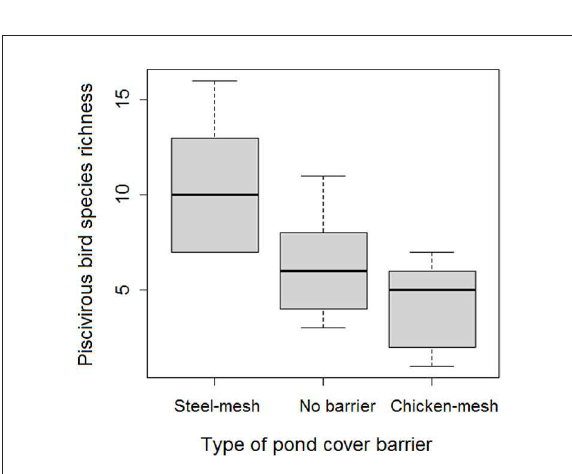
FIGURE2 Comparison of piscivorous bird mean species richness across the three pond cover barrier types. Species richness was the average daily total number of species encountered across ponds covered by each cover barrier type over the entire study period.